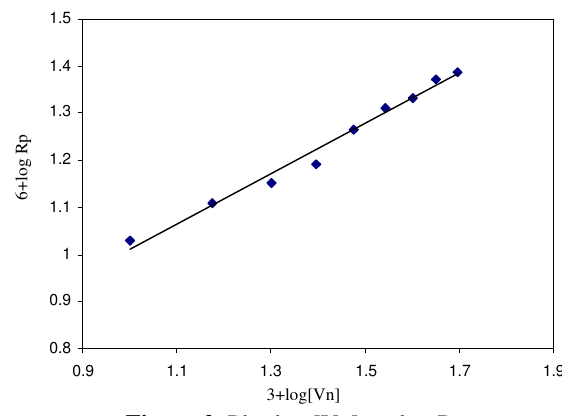
Figure 2. Plot log [Vn] vs. log